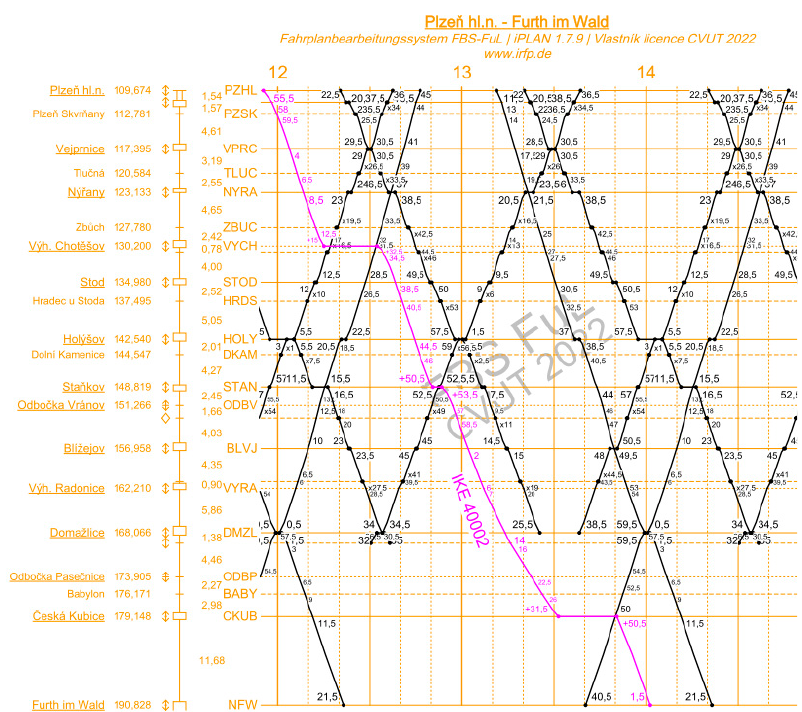
Figure 4. Proposed freight train path on the rail line 180—direction to Furth im Wald (data: [1,26]). Source: Authors.